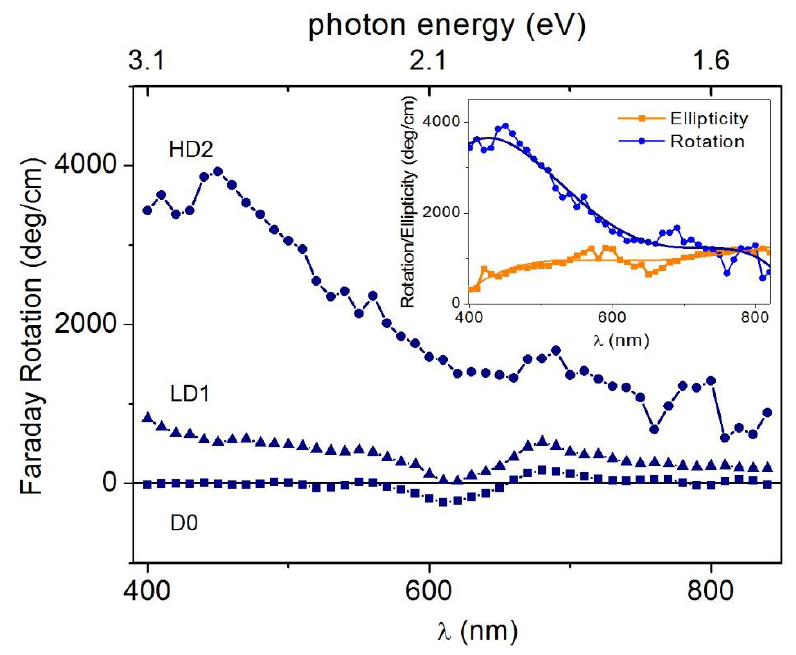
Figure 10. Room temperature Faraday rotation at 1.3 T for unirradiated D0, and the low (high) H-dose- treated sample LD1 (HD2) film. Inset: Faraday rotation and ellipticity for the HD2 sample; lines are a guide to the eye. Reproduced with permission from [74]. Copyright 2019 Royal Society of